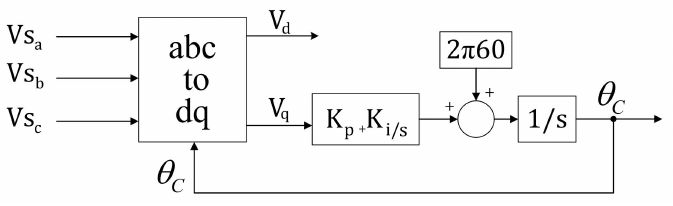
Figure 4. Conventional PLL.